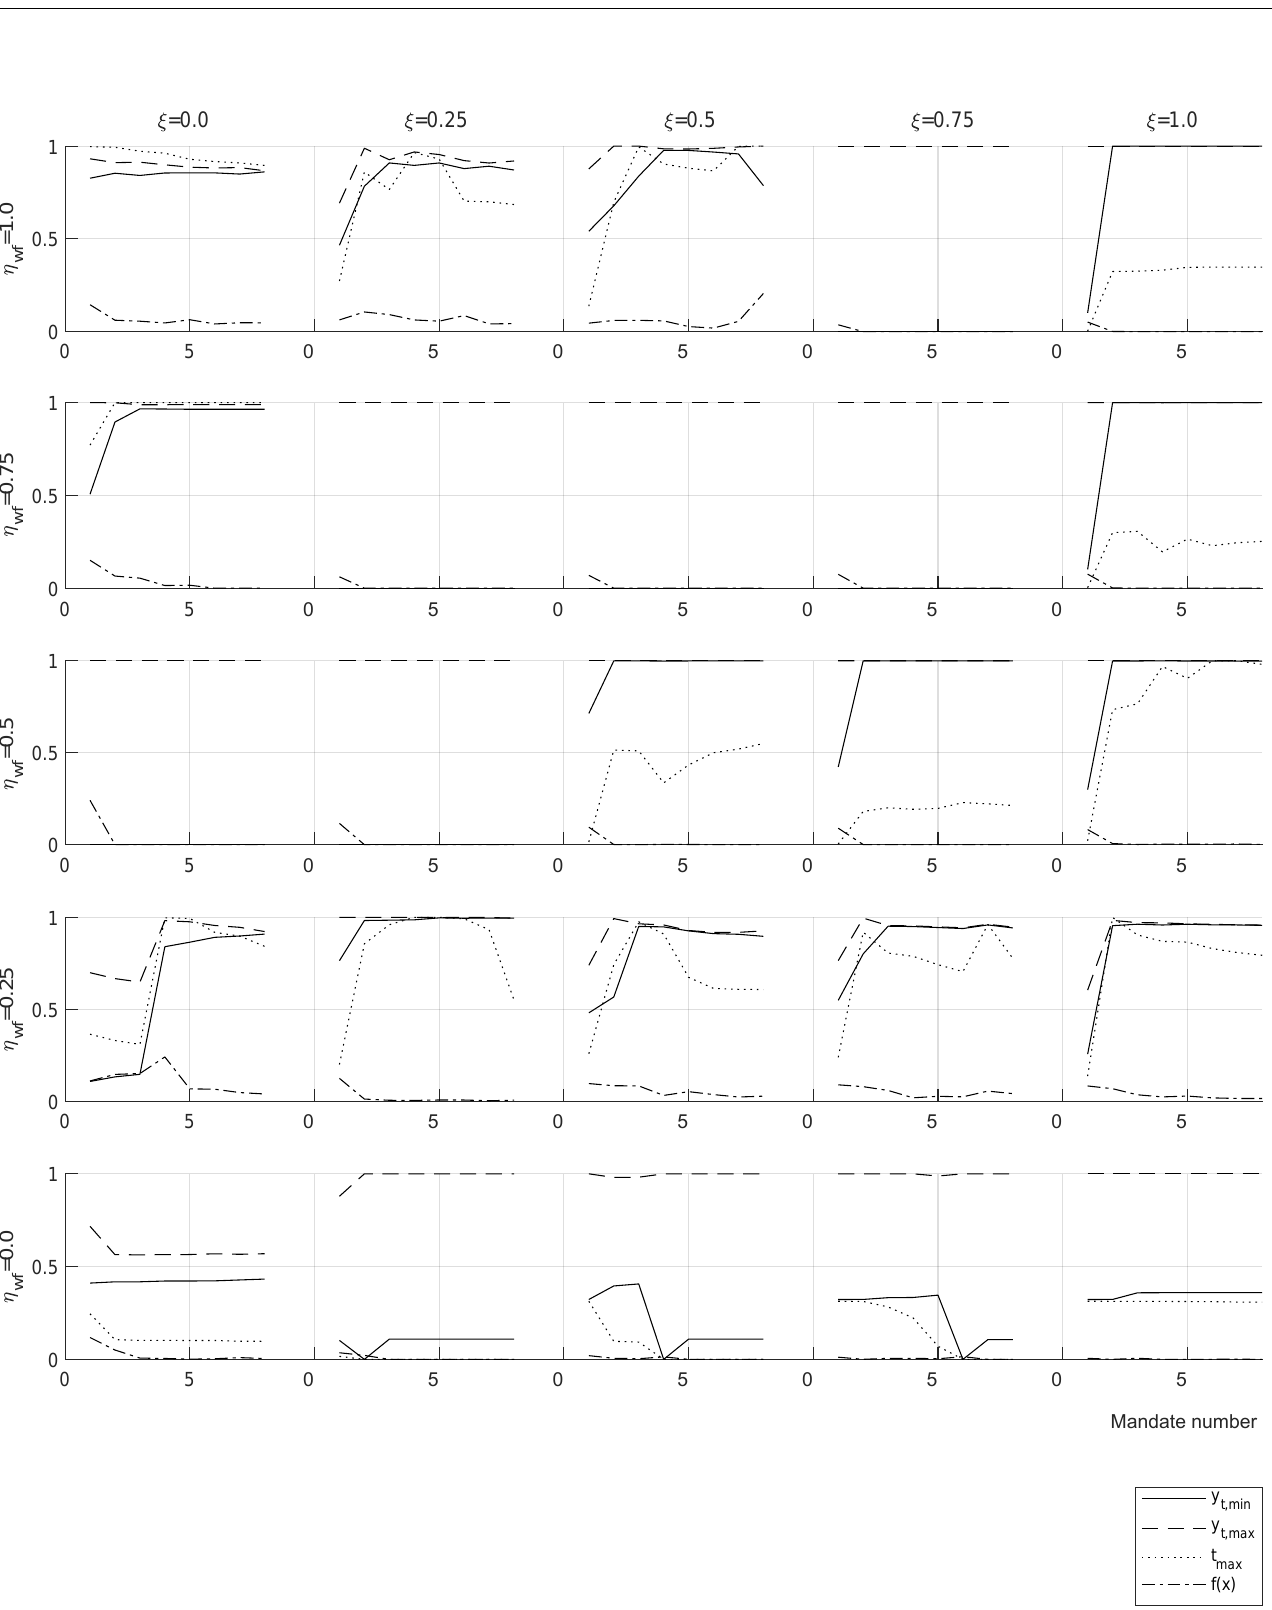
Figure A7. Tax policy evolution under yardstick vote during eight mandates for a series of welfare efficiency values η wf and tax disincentive ξ . Per citizen criterion. Mandate length: 8 years. Voters improvement demand